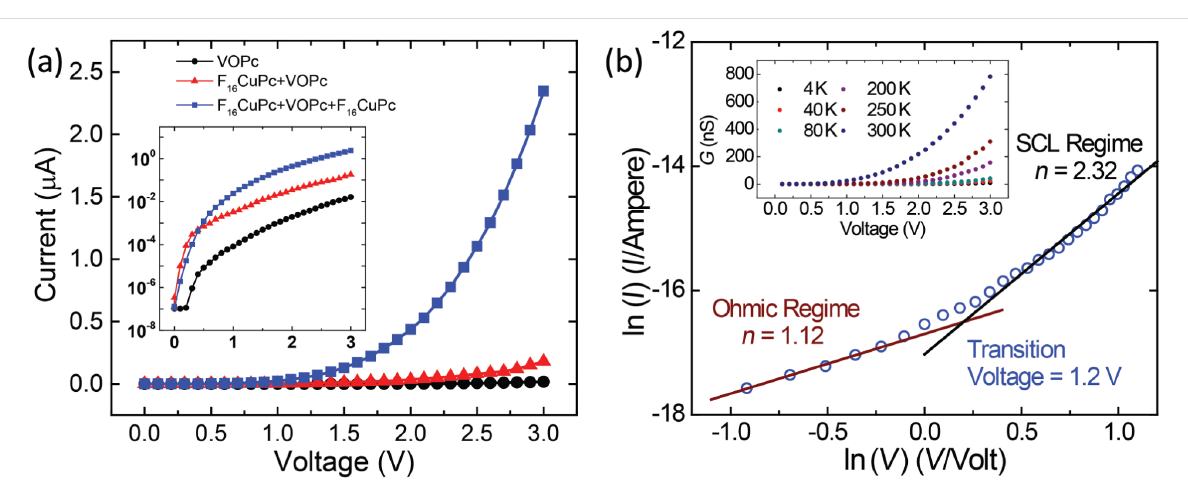
Figure 2: (a) I – V characteristics of three kinds of nanopyramid structures: pure VOPc (black), F 16 CuPc/VOPc (red) and F 16 CuPc/VOPc/F 16 CuPc (blue), (b) ln( I )–ln( V ) plot showing the transition of transport regimes from ohmic to SCL.